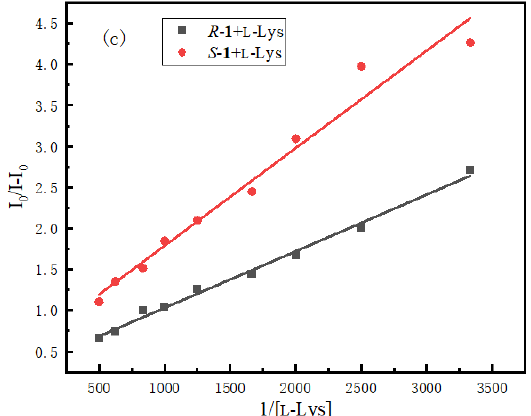
Figure 7. ( a , b ) Fluorescence spectra of R - 1 and S - 1 (2.0 × 10 −5 M in CH 3 OH) upon titration with L - Lys (1.0 × 10 −3 M); ( c ) Benesi – Hildebrand plots of R - 1 and S - 1 titration with L -Lys.